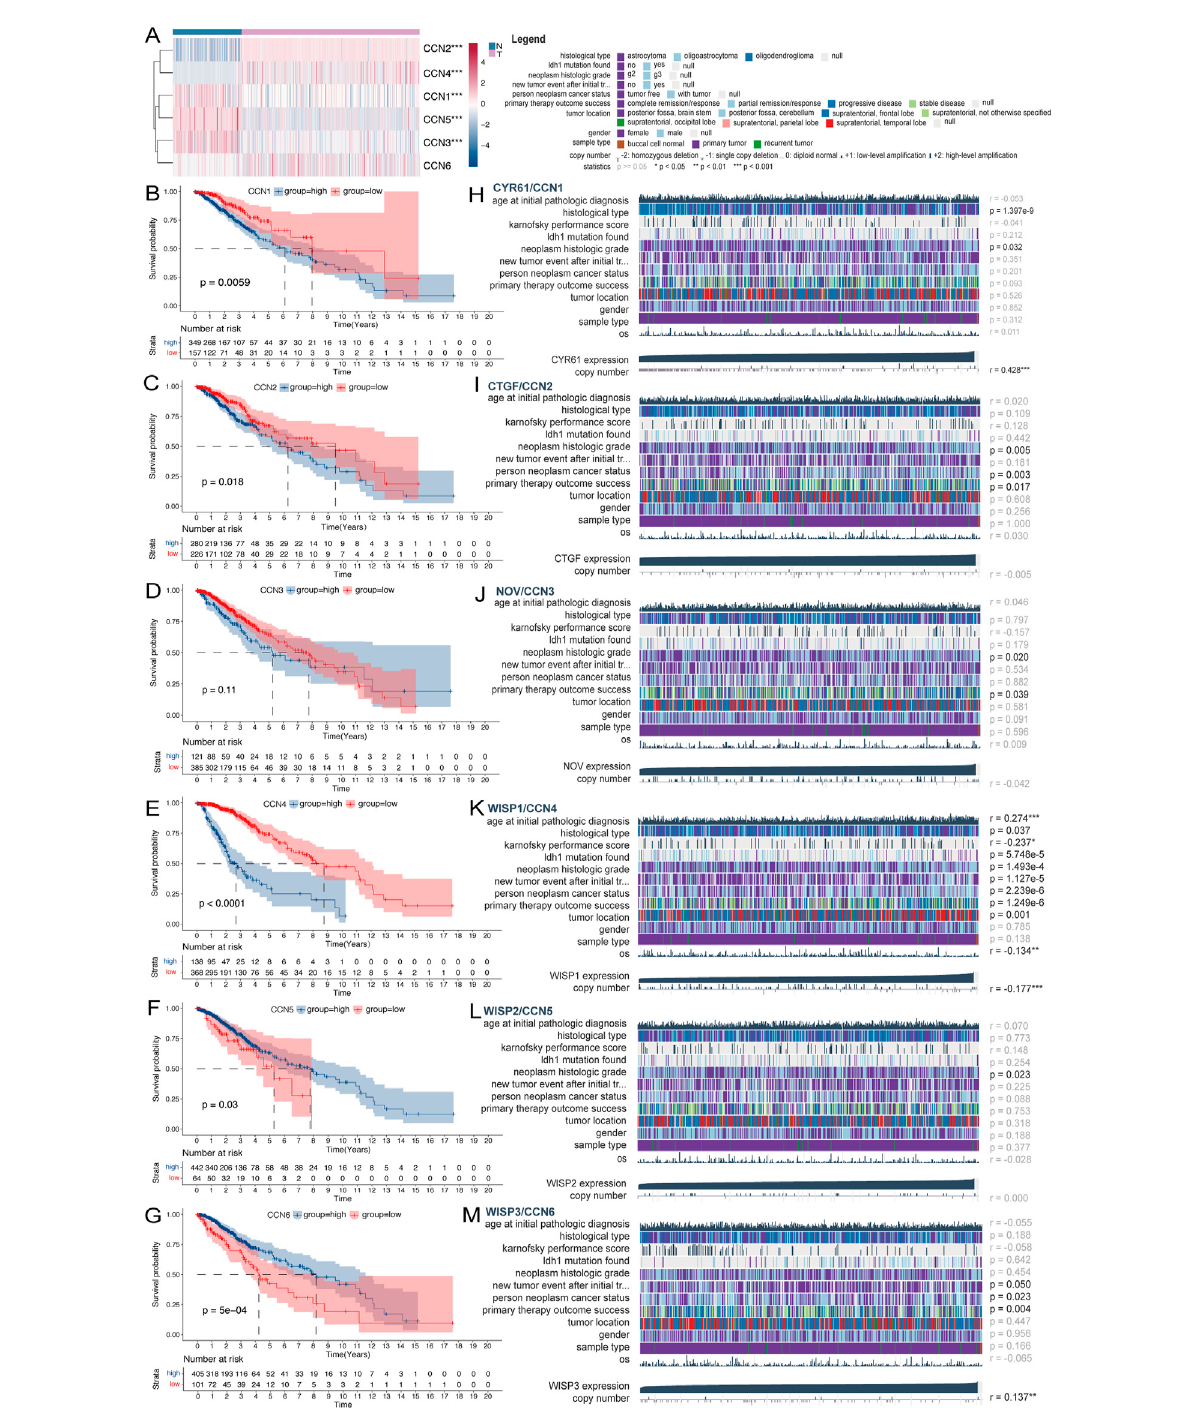
FIGURE 2 Expression and clinical value of the CCN family in LGG. (A) Heatmap of differential expression analysis of CCN family between normal cortex ( n =207)andTCGA-LGGcohort( n =529). (B – G) Kaplan-MeiersurvivalanalysiswasperformedusingtheoptimalcutoffvaluetodistinguishtheCCN genes between high and low subgroups in the TCGA-LGG cohort. (H – M) Correlation heatmap of CCN family expression versus clinical traits in the TCGA-LGG cohort using the MEXPRESS database. Each column in the graph represents a sample, while each row represents a variable. OS, overall survival. For all experiments, mean rank, * p < 0.05, ** p < 0.01, *** p <